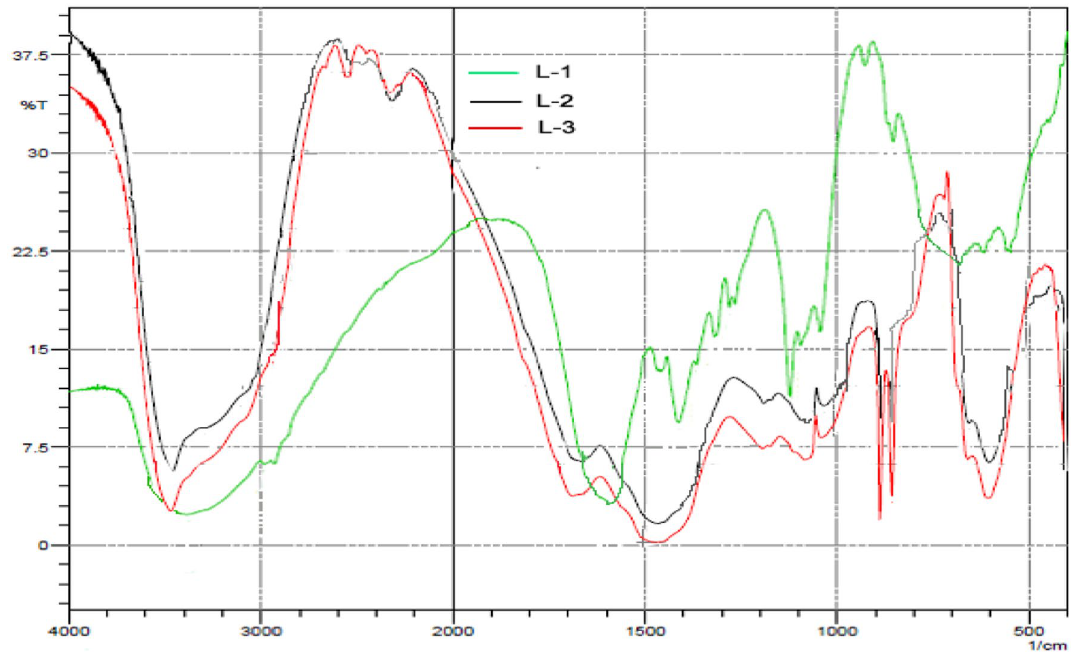
Fig. 1 The FT-IR spectra of DOM samples showing changing chemical bonds over